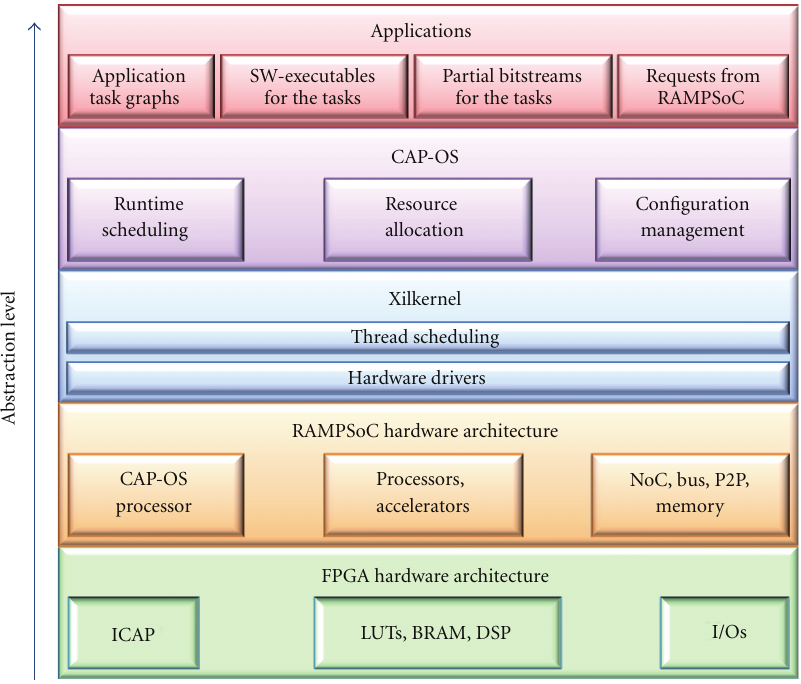
Figure 3: CAP-OS embedded in the several abstraction layers of the system